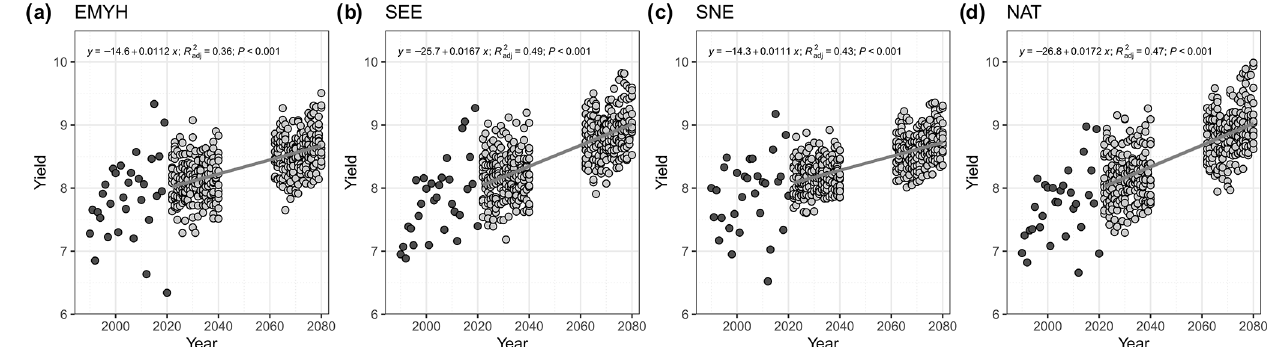
Figure 6. Temporal trends in wheat yields (tha − 1 ): observations and future projections. The observations (black circles, 1990–2020) are the same as in Fig. 1. The projections (grey circles; 12 members per year) are obtained by forcing a multiple linear regression model (Eq. 1; Table 4) obtained for each region with the UKCP Local projections of the same climate variables in each growth stage (see Sect. 2.5). Grey lines indicate the linear regressions between the ensemble of projected values and time (the regression equation, adjusted R 2 , and p value are indicated in each